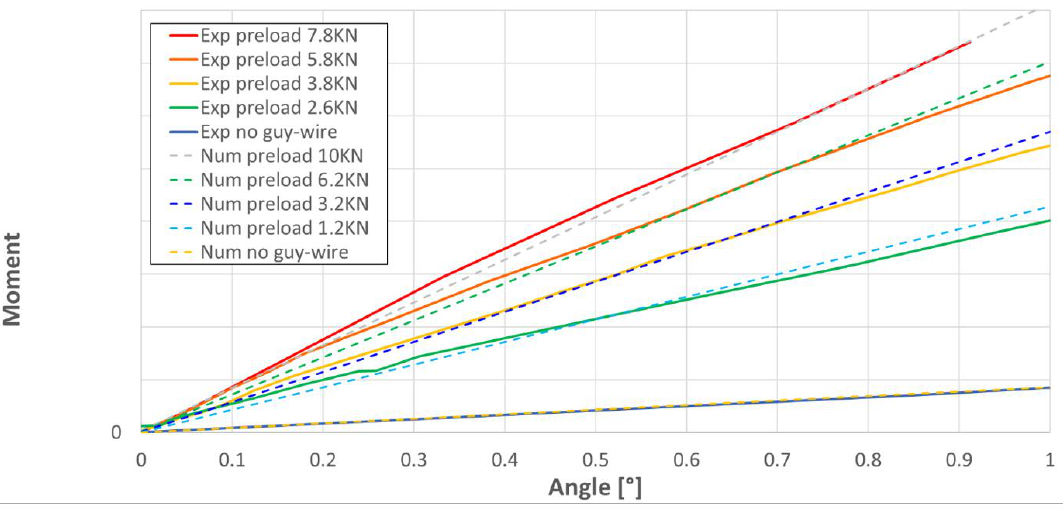
Figure 24. Numerical results of the differential torsion tests compared with the experiments.